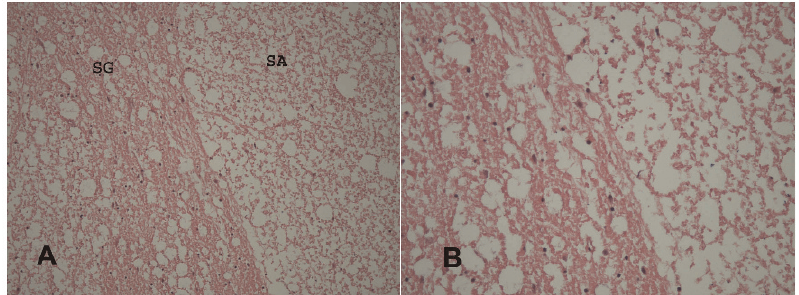
Figure 2 - Spinal cord samples of the I/R group with paraplegia exhibited complete destruction of the motor neurons, with intensely eosinophilic cytoplasm, the loss of Nissl granules and the pronounced vacuolization of the substantia alba (SA) and the substantia grisea (SG). A) Hematoxylin and eosin (H&E)-stained spinal cord tissues at 200 6 magnification and B) H&E-stained spinal cord tissues at 400 6 magnification.